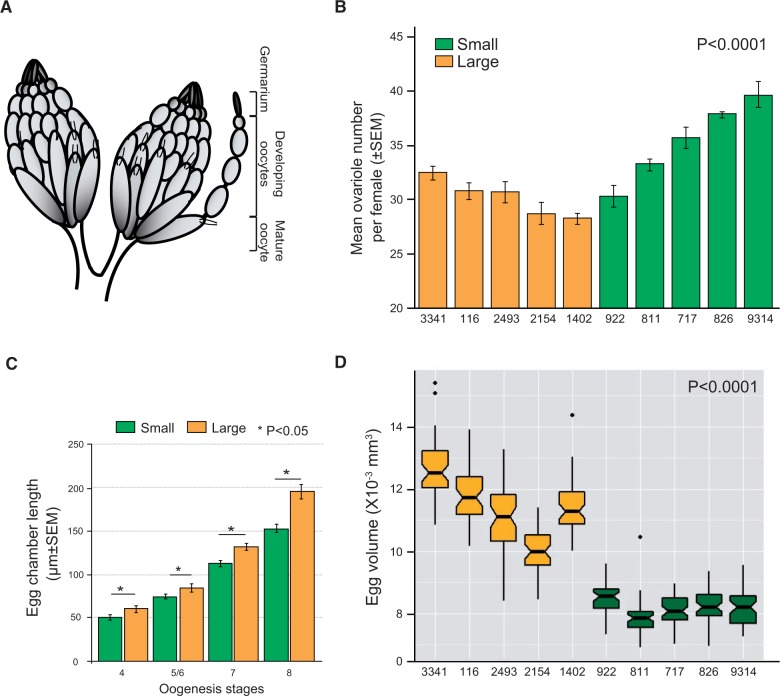
Ovariole numbers and egg chamber lengths. (A) Graphical representation of the Drosophila melanogaster ovaries with ovarioles extending out with egg chambers at various developmental stages. (B) Mean ovariole numbers per female (±SEM) in ten isofemale lines derived from the large (yellow) and small (green) selected populations (n = 10 pairs per line) are shown. P value was obtained from a nested ANOVA performed to compare ovariole numbers between large and small populations by nesting lines within the treatments. Both lines and treatments were significant. (C) Difference in mean (±SEM) egg chamber lengths between a large and a small line at various stages of oogenesis. (D) Egg volumes of isofemale lines derived from the large (yellow) and small populations (green, n = 50 per line). The boxes indicate the first and third quartiles and the whiskers indicate the interquartile ranges (1.5* IQR).